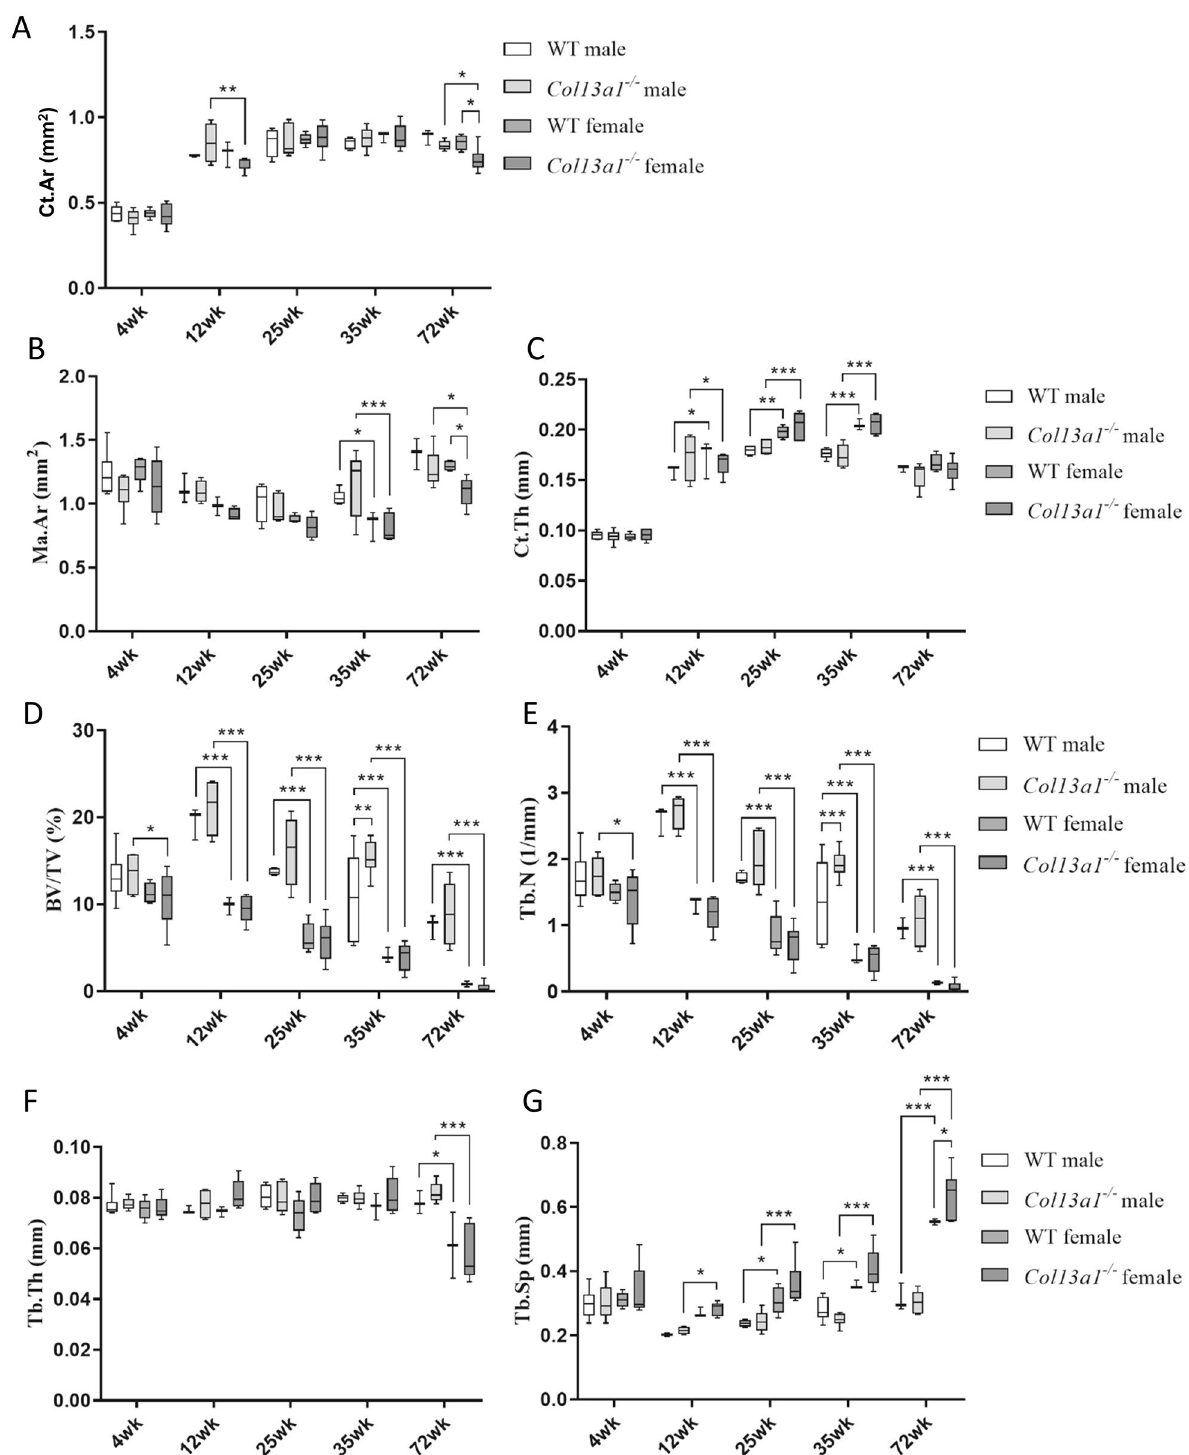
Figure 3. Summary of morphometric parameters of diaphyseal cortical bone and distal femoral trabecular bone of male and female Col13a1 −/− mice and WT controls. Cortical area (Ct.Ar, A ) and medullary area (Ma. Ar, B ) were significantly reduced in the female Col13a1 −/− mice at the 72-week compared to the controls. There was no differences in cortical thickness (Ct.Th., C ) between genotypes. Bone volume fraction (BV/TV, D ) and trabecular number (Tb.N, E ) were higher in 35-week-old Col13a1 −/− males compared to WT. There was no differences in trabucular thickness (Tb.Th., F ) between genotypes. Trabecular separation (Tb.Sp, G ) was higher in 72-week-old Col13a1 −/− females compared to WT. n(WT male): 3–6; n( Col13a1 −/− male): 4–7; n(WT female): 3–5; n( Col13a1 −/− female): 5–6; the whiskers represent min to max; *q < 0.05, **q < 0.01, ***q < 0.001 determined by two-way ANOVA and followed by the false discovery